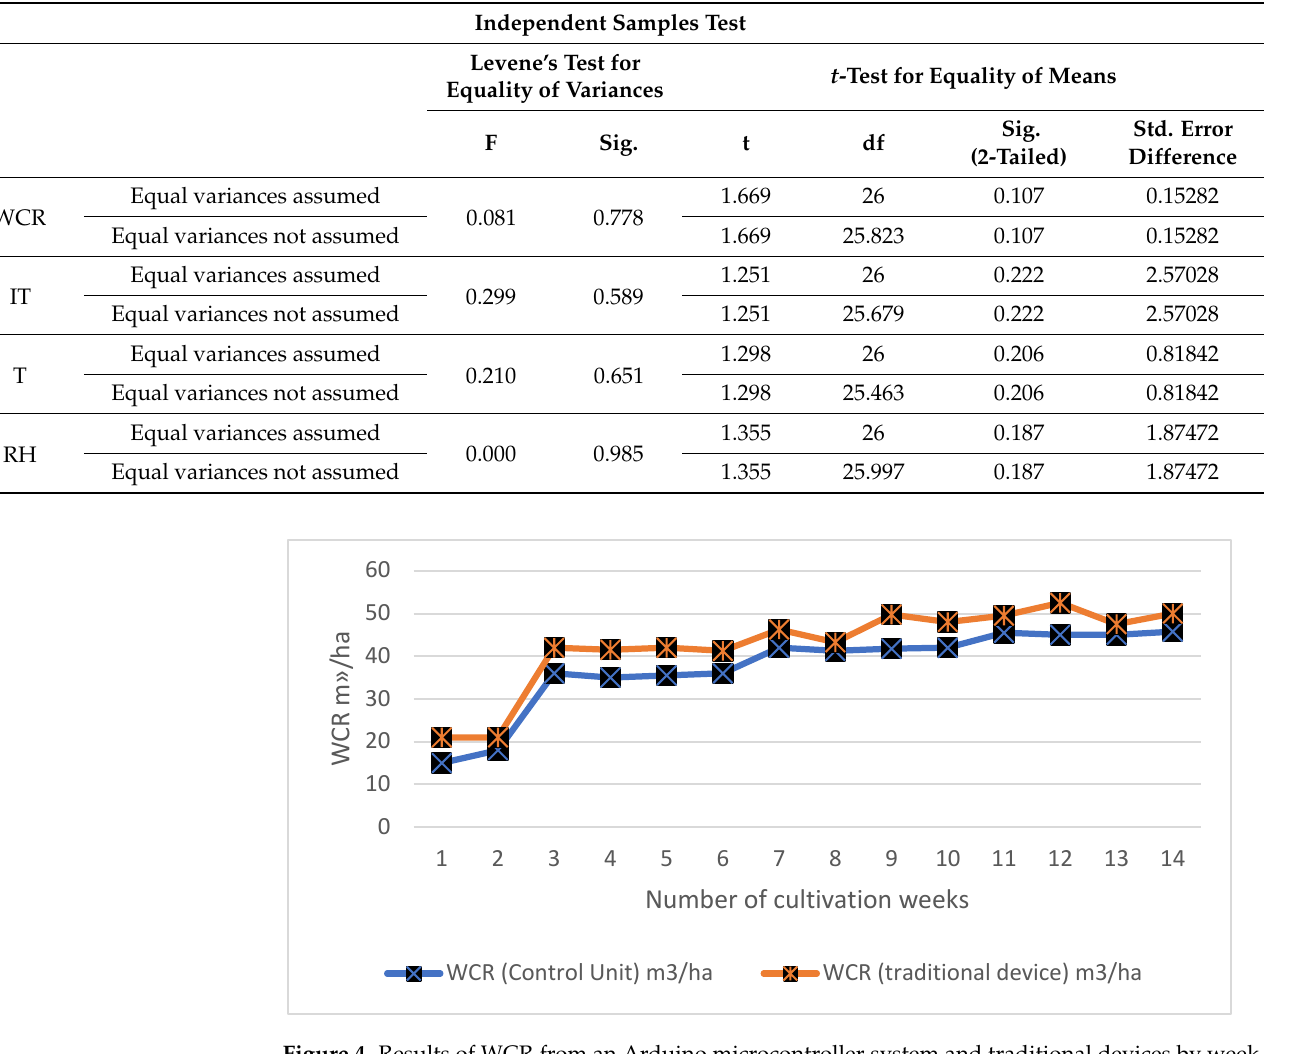
Figure 5. Results of IT from an Arduino microcontroller system and traditional devices by week. Figure 6. Results of T from an Arduino microcontroller system and traditional devices by week.